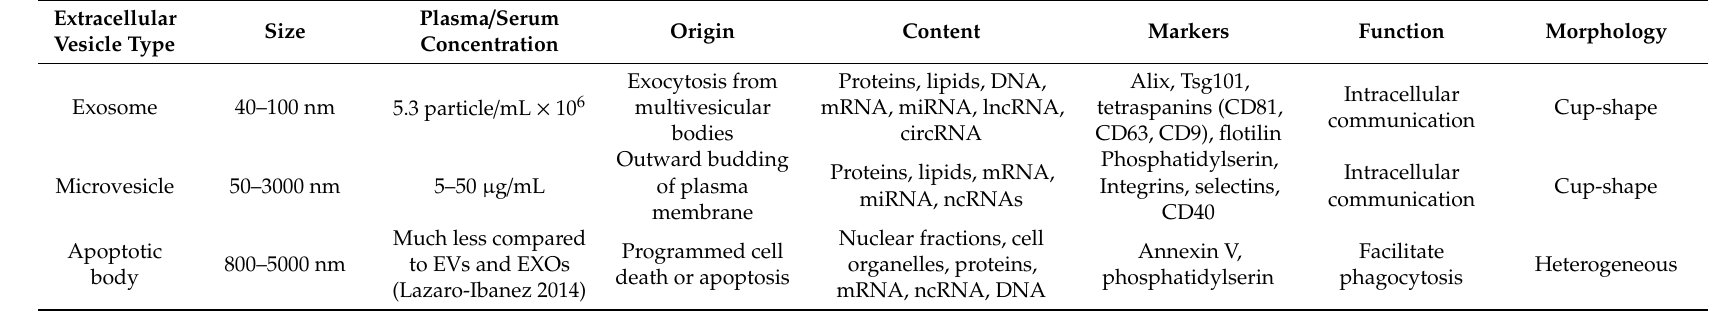
Table 1. Main characteristics of extracellular